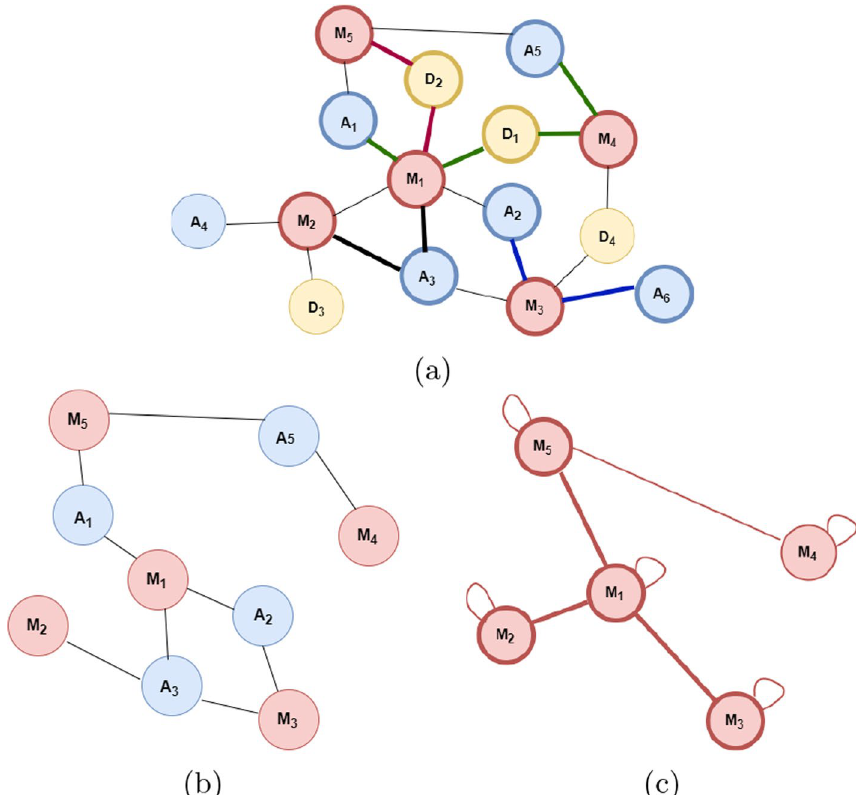
Fig. 4 Examples of meta-path instances for types MAM ( movie – actor – movie ) marked with bold black lines, MDM ( movie – director – movie ) marked with bold red lines, AMA ( actor – movie – actor ) marked with bold blue lines, and AMDMA ( actor – movie – director – movie – actor ) marked with bold green lines, w.r.t. layer G l in the multilayer graph of Fig. 1 ( a ), all meta-path instances of type MAM w.r.t. the same layer ( b ) and the corresponding meta-path based graph for MAM type, with focus on node M 1 and its neighbors ( c